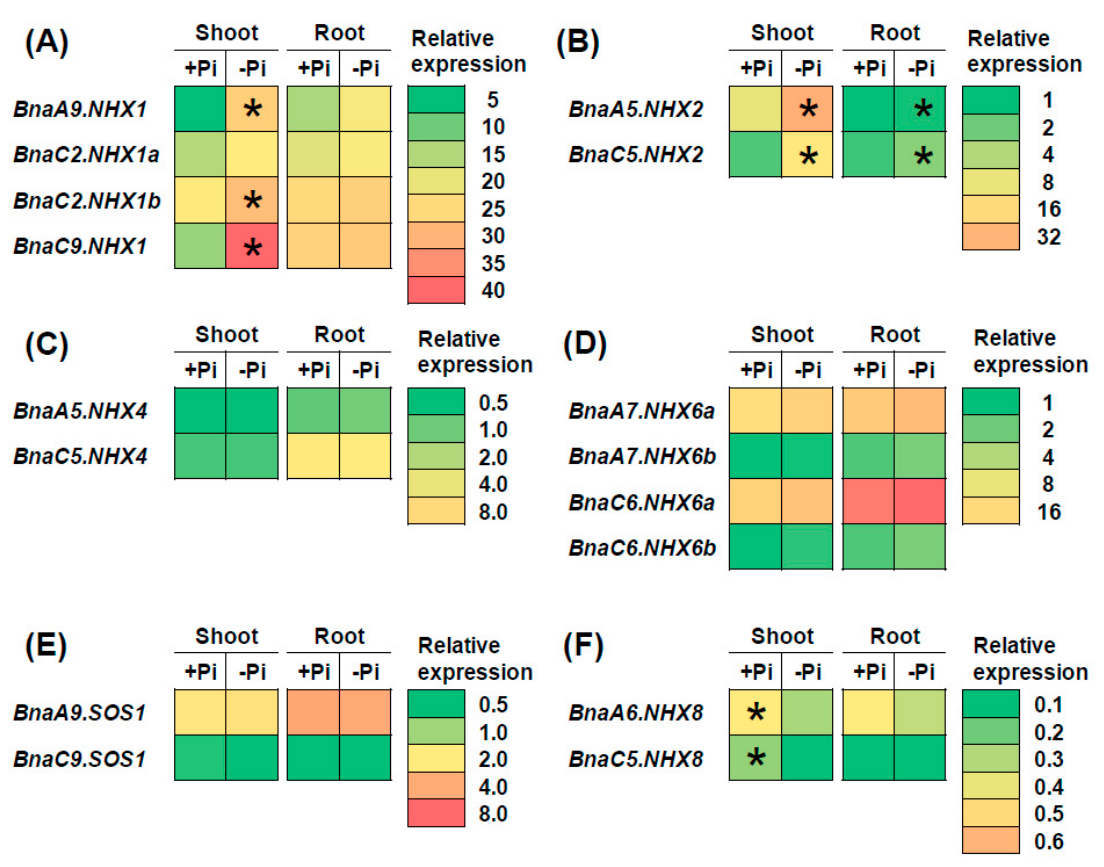
Figure 9. The qRT-PCR-assisted transcriptional characterization of the Na +/ H + antiporters ( NHXs ) in Brassica napus under di ff erent phosphate (Pi) levels. Di ff erential expression of BnaNHX1s ( A ), BnaNHX2s ( B ), BnaNHX4s ( C ), BnaNHX6s ( D ), BnaNHX7s ( E ), and BnaNHX8s ( F ) under high Pi and low Pi levels. For the transcriptional analysis, the 7 d-old uniform B. napus seedlings after seed germination were first hydroponically grown under 250 µ M KH 2 PO 4 ( + Pi) for 10 d, and then were transferred to 5 µ M KH 2 PO 4 (-Pi) for 3 d until sampling. The shoots and roots were individually sampled, and each sample includes three independent biological replicates. The significance level of P < 0.05 is used as the threshold to identify the di ff erential expression of BnaNHXs under high Pi and low Pi conditions. The di ff erentially expressed genes with higher expression are indicated with